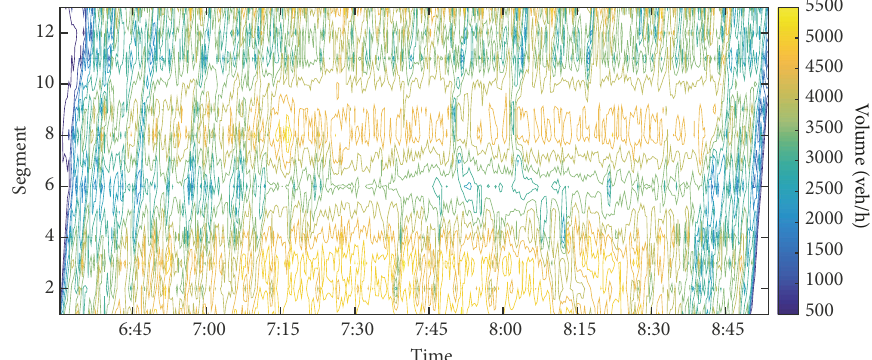
Figure 7: Volume variation at different segments without